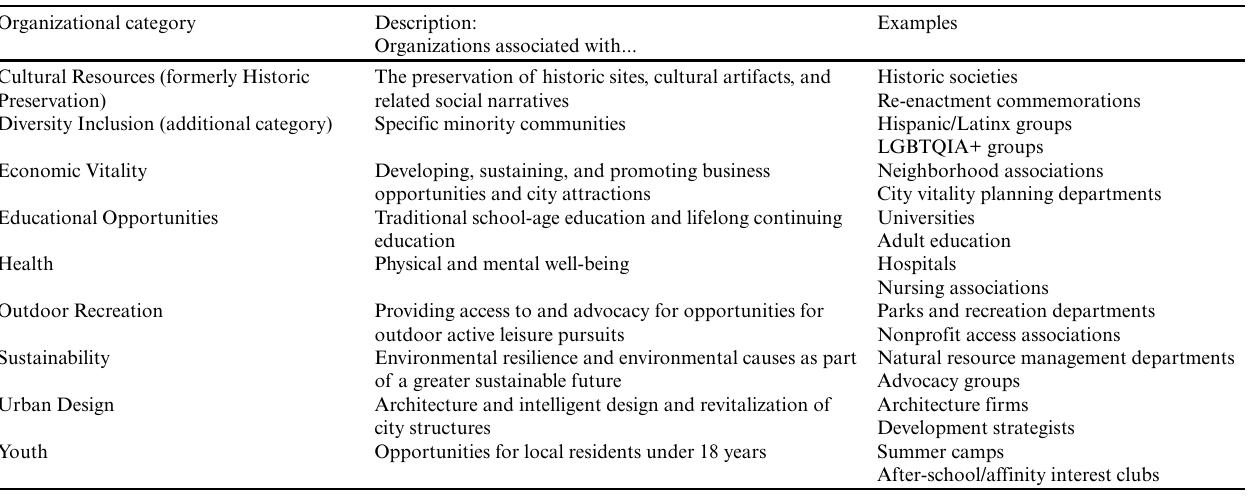
Table 1 . National Park Service Urban Agenda typology of organizational categories, with descriptions and examples of each category. Organizational category Description: Organizations associated